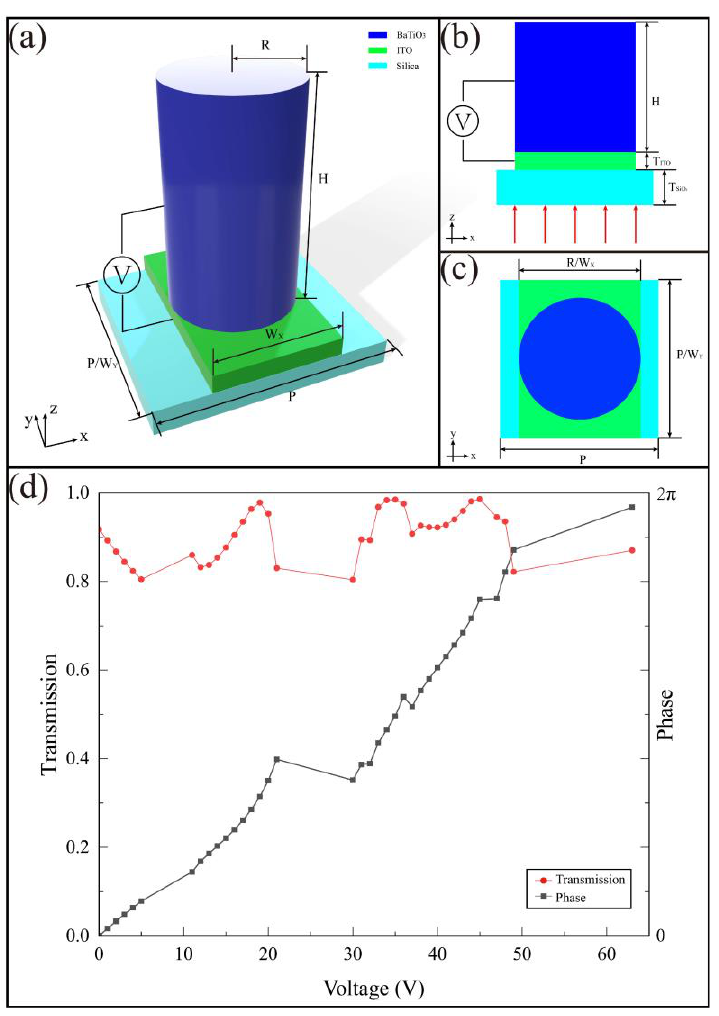
Figure 2. ( a – c ) Diagrams of the meta-atom. Along with the longitude, the materials are BTO ( R = 0.17 μm, H = 0.5 μm), ITO ( T ITO = 0.1 μm, W x = 0.34 μm), silica ( T Silica = 1 μm), and the lattice constant P = 0.4 μm; ( d ) the transmission (red line) and phase change (black line) of meta-atom when the applied voltage of BTO changes from 0 V to 63 V by commercial software FDTD Solutions (Lumerical Inc.).